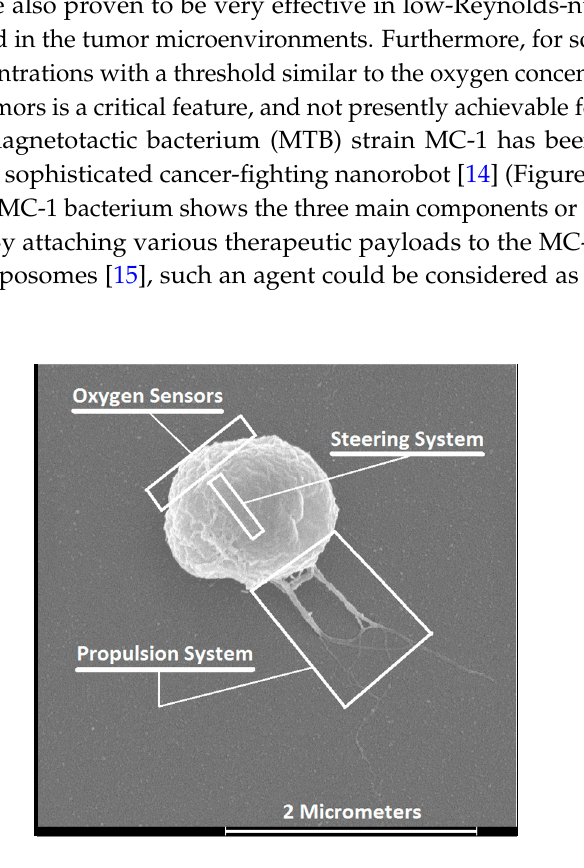
Figure 2. Main nanorobotic components or subsystems identified on a field-emission photograph of the MC-1 cell. The propulsion system consists of two bundles of flagella activated by rotary molecular motors with a design similar to the ones found in modern engineered electrical motors. Flagellated propulsion is known to be very effective in low-Reynolds-number hydrodynamic conditions. Computer-controlled direction is provided by an embedded steering system consisting of a chain of membrane-based magnetic nanoparticles acting as a miniature compass needle. Oxygen sensory capability can influence the motion of the cell towards the hypoxic regions when the torque induced on the steering system from a directional magnetic field becomes negligible (Adapted from [16].